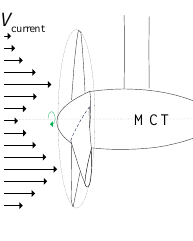
Figure 3. Long-term tidal velocity.